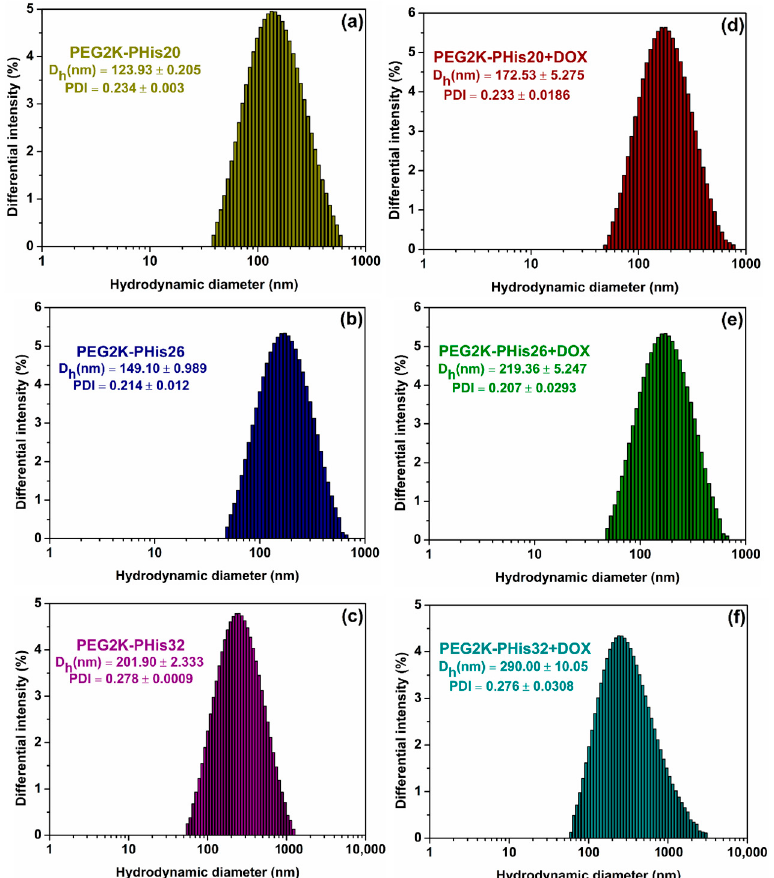
Figure 2. Distributions of average hydrodynamic diameters measured using dynamic light scattering (DLS) of unloaded micelles ( a – c ) and those loaded with DOX ( d – f ).